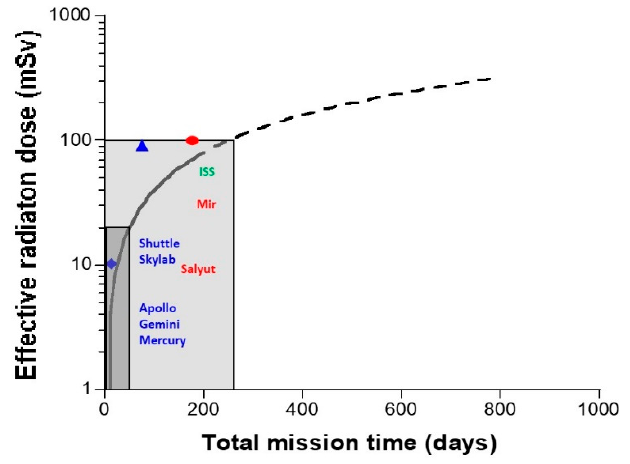
Figure 2. Schematic representation of effective dose per day of space mission. Left panel. The black solid line and its dotted line extension represents the average over the whole duration of the mission from all of the space mission’s on-board dosimetry data until 1990s [6]. Blue losange, blue triangle and red circle represent the Apollo XIV, Skylab4 and Mir 15 missions’ on-board dosimetry data, respectively. Dark and light grey zones represent the annual and the 5-year limits of occupational exposure to ionizing radiation (IR) (20 mSv/y and 100 mSv/y, respectively).